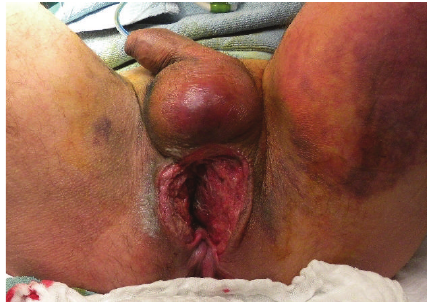
Figure 7: The dorsal urethral diverticulum (long white arrow), adjacent to the urethral lumen (short white arrow), as seen on MR examination. V = vagina; A =